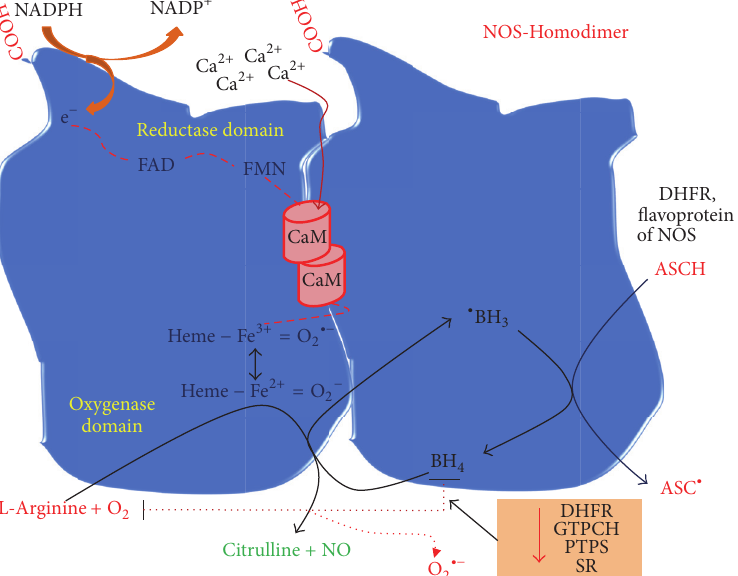
Figure 1: Pictorial presentation of NO production from arginine by nitric oxide synthase (NOS) . FAD: flavin adenine dinucleotide; FMN: flavin mononucleotide; NADPH: nicotinamide-adenine-dinucleotide phosphate; CaM: calmodulin; BH 4 : tetrahydrobiopterin; ASCH: ascorbic acid; DHFR: dihydrofolate reductase; GTPCH: GTP cyclohydrolase I; PTPS: 6-pyruvoyl-tetrahydropterin synthase; SR: sepiapterin reductase.